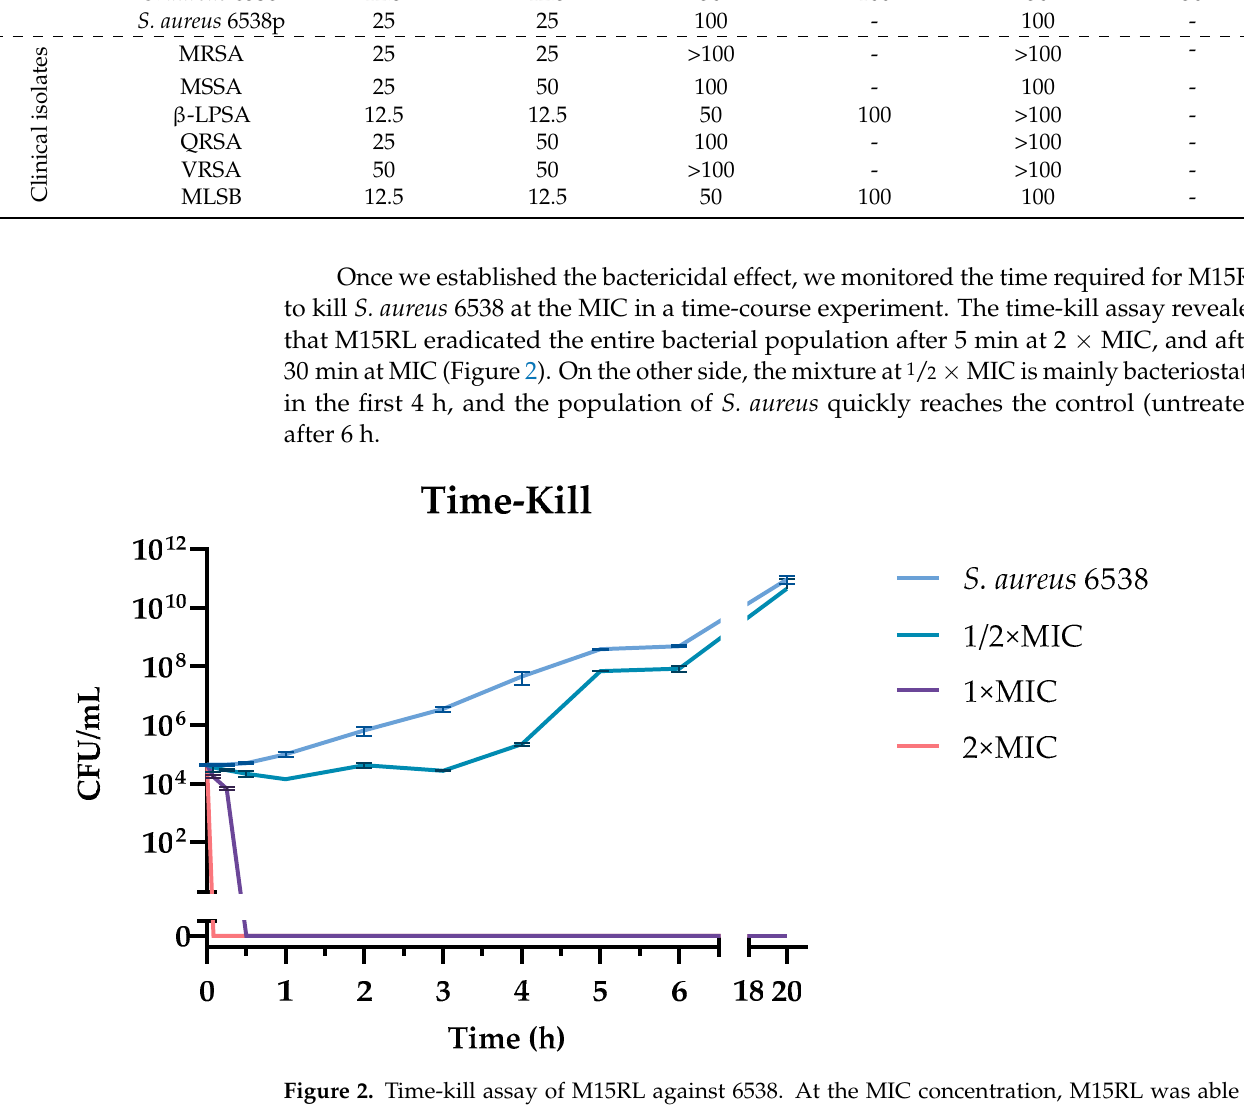
Figure 2. Time-kill assay of M15RL against 6538. At the MIC concentration, M15RL was able to completely eradicate the bacterial load in 30 min. It requires just 5 min at 2 × MIC.